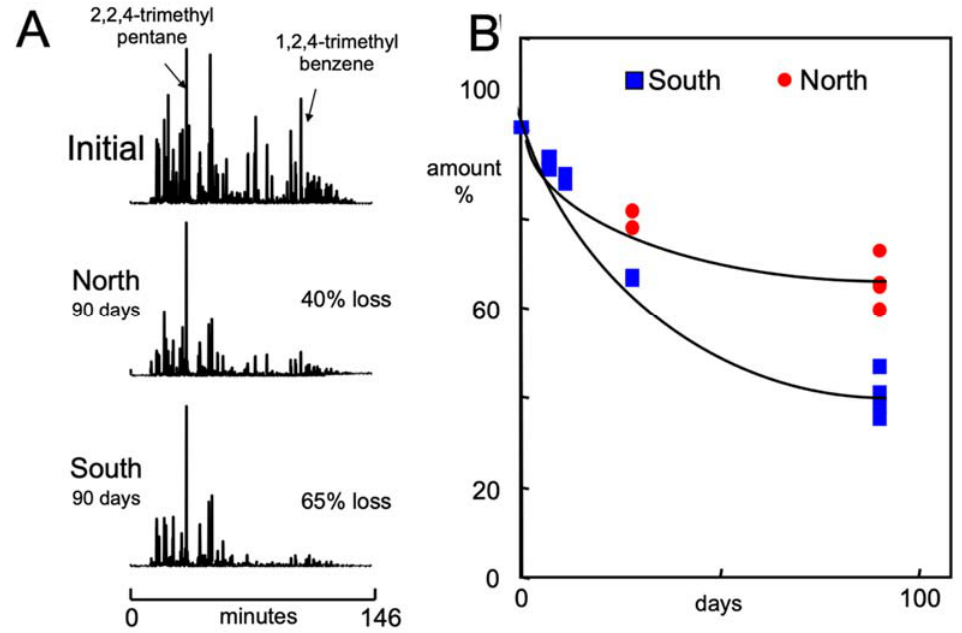
Figure 1. Purge-and-trap total ion chromatograms of the initial gasoline, and of gasoline exposed to water from the South and North Arms of the Great Salt Lake for 90 days of incubation ( A ). The chromatograms are normalized to 2,2,4-trimethylpentane ( iso -octane), and the lines in panel ( B ) are to guide the eye.